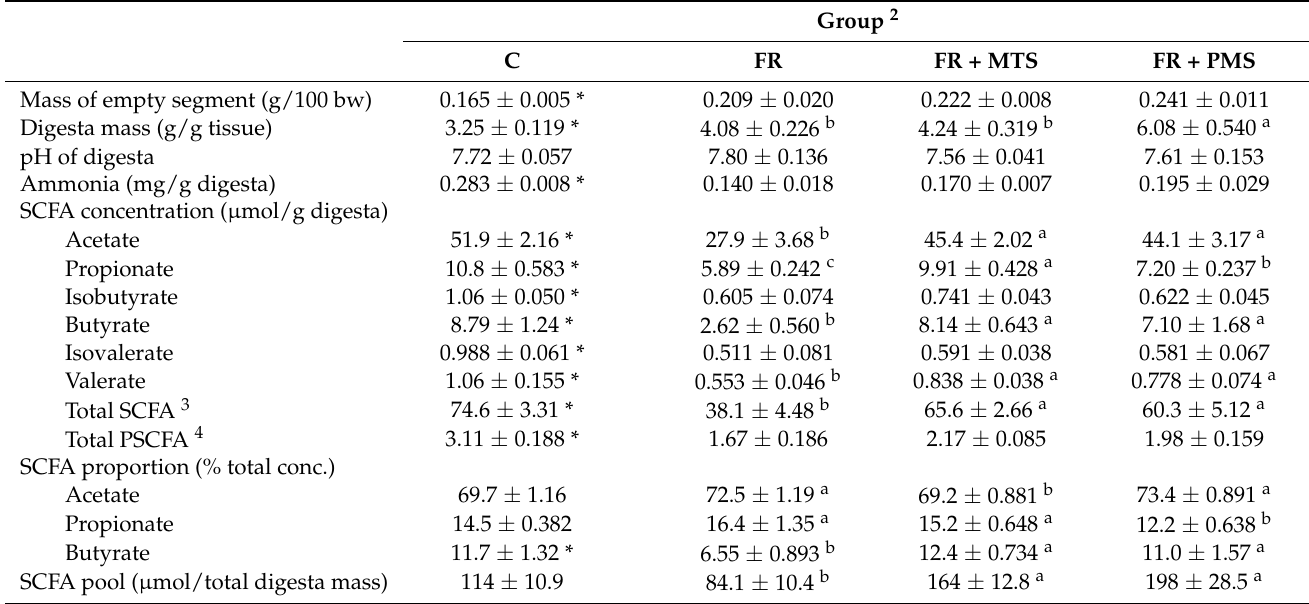
Table 3. Caecal metabolism in rats after 4 weeks of feeding with a fibre-rich (FR) diet containing milk thistle seeds (MTSs) or pot marigold seeds (PMSs) 1